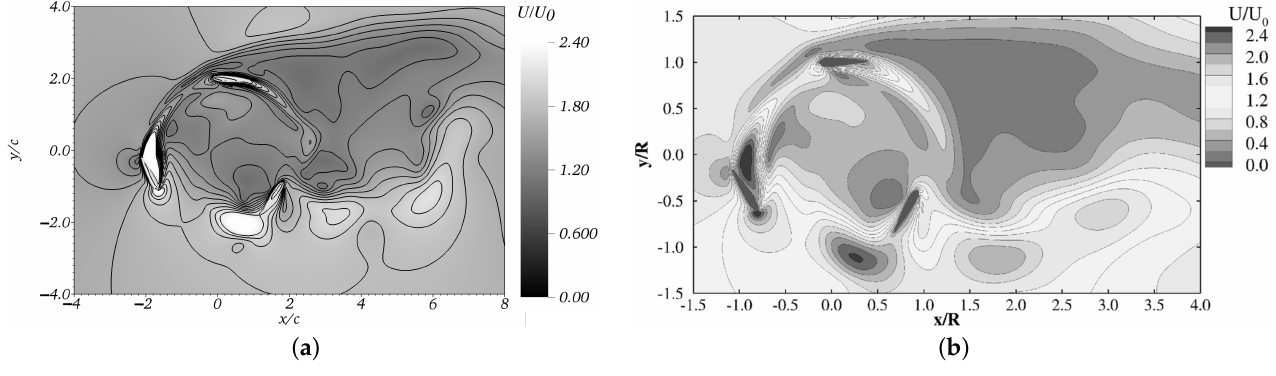
Figure 18. Isolines of the absolute velocity field over the turbine in θ = 720 ◦ . ( a ) Present work. ( b )